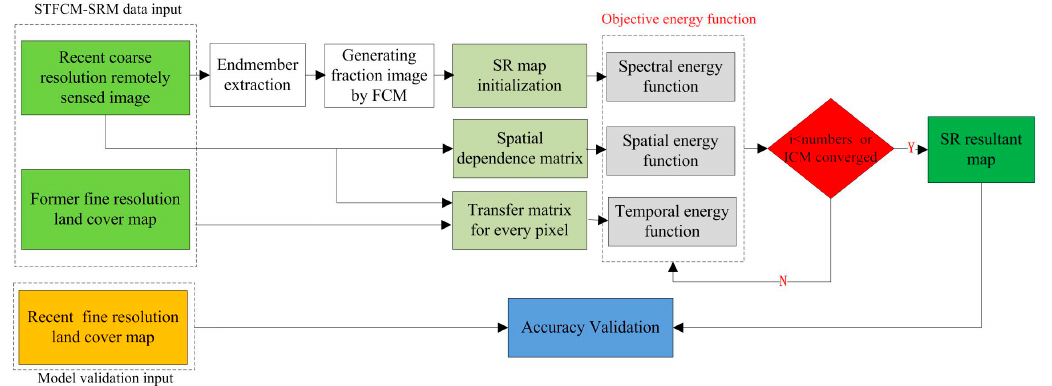
Figure 3. Flowchart of the proposed fuzzy c-means clustering (FCM)-based spatio-temporal SRM